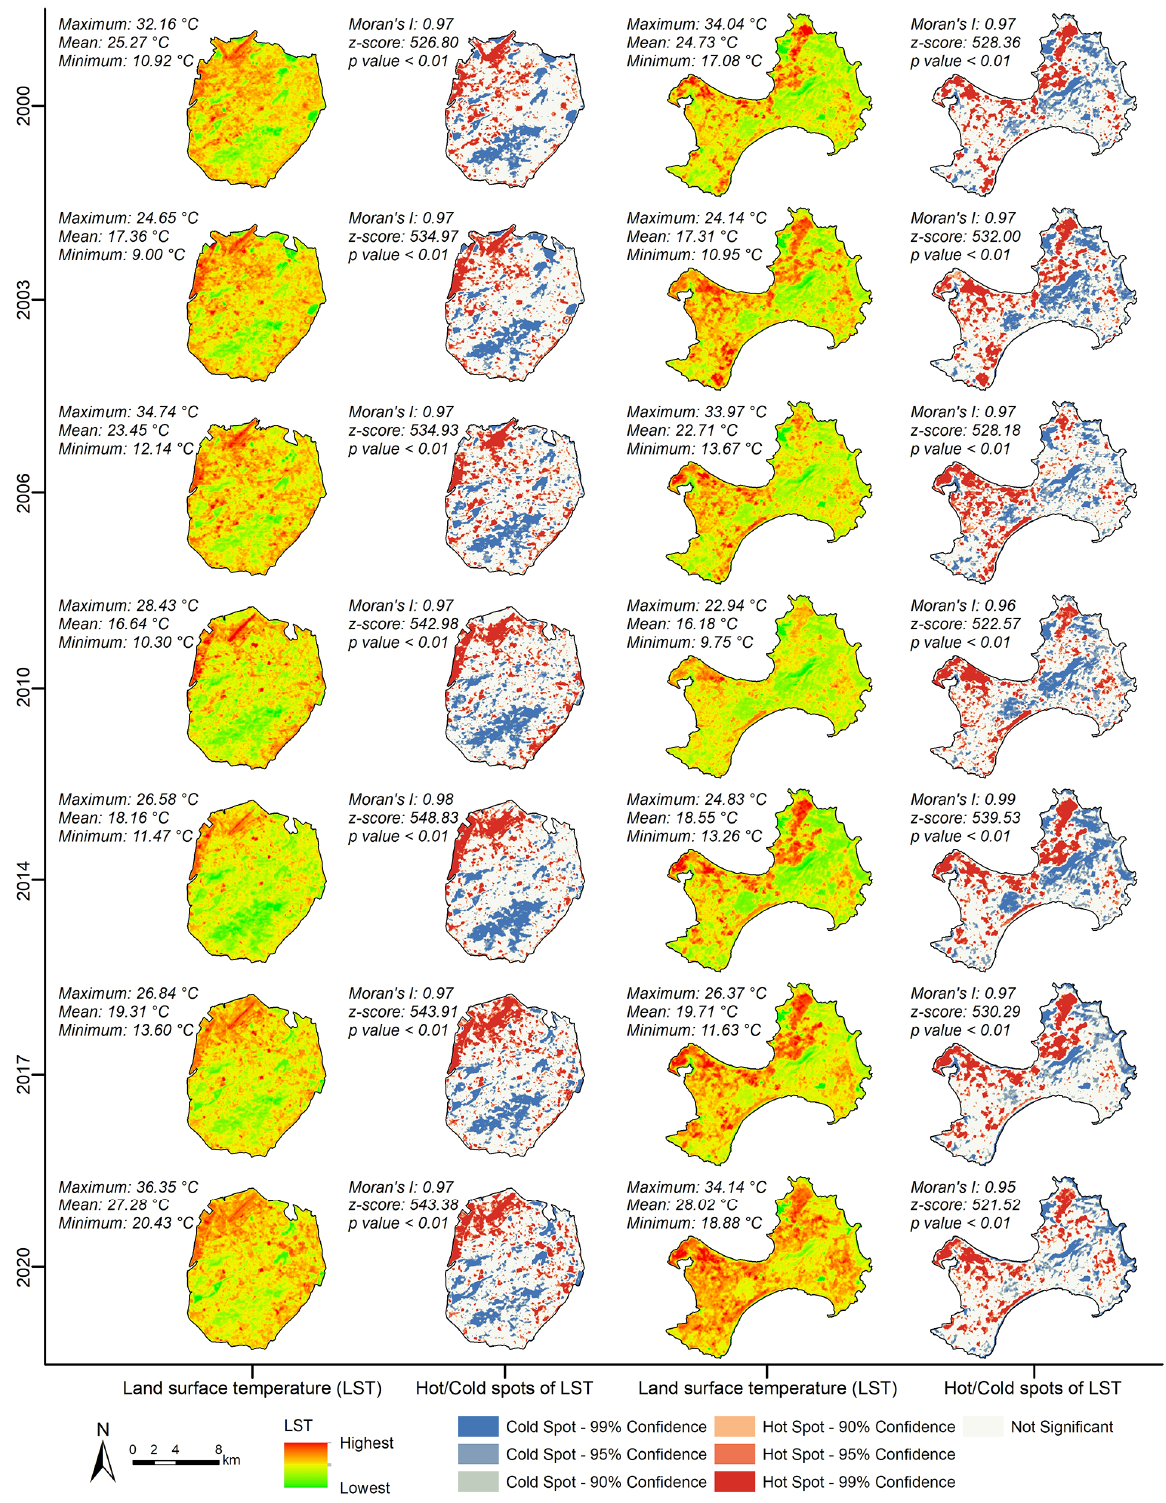
Figure 2. LST and its spatial heterogeneity in the two inhabited islands from 2000 to 2020.